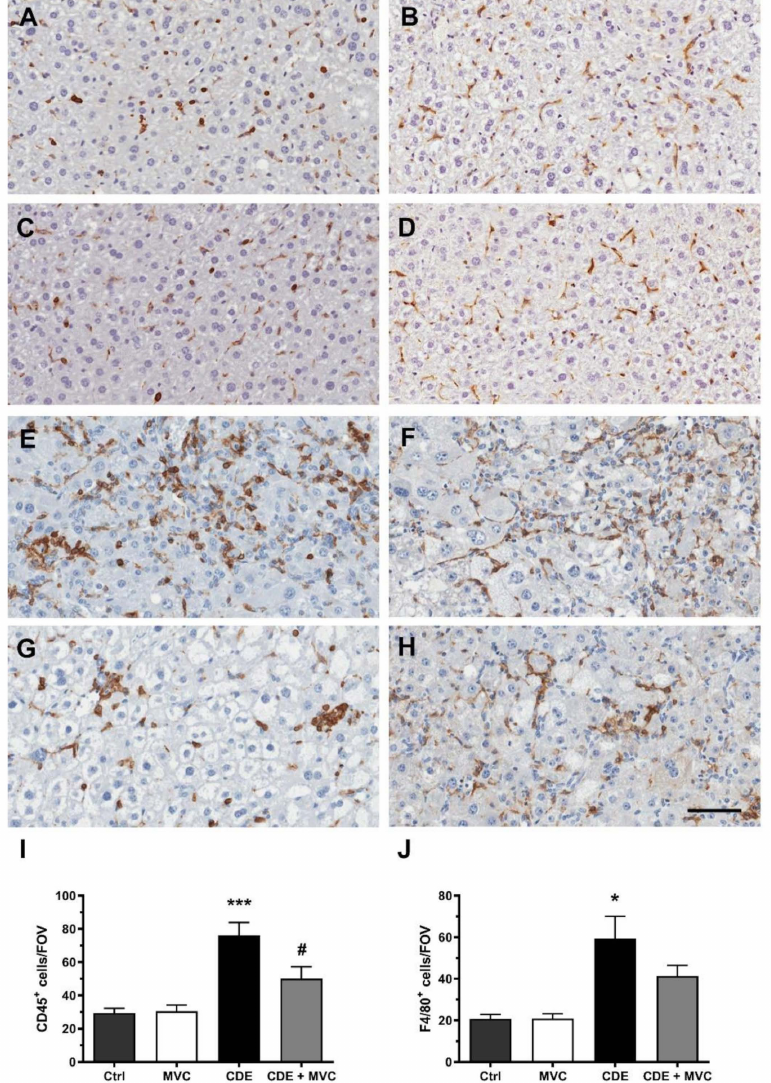
Figure 6. Resident and infiltrating inflammatory cell numbers are attenuated by MVC in CDE liver. Representative images of histological sections stained with CD45 ( A , C , E , G ) or F4/80 ( B , D , F , H ) in Ctrl ( A , B ), MVC ( C , D ), 16-wk CDE ( E , F ) and CDE+MVC ( G , H ) animal groups. ( I , J ) Quantitation of CD45+ and F4/80+ cell numbers per field of view by the inForm software. Bars represent the mean ± SEM for 8, 11, 6 and 14 animals in the Ctrl, MVC, CDE and CDE+MVC groups, respectively. * p < 0.05, *** p < 0.001, compared to Ctrl. # p < 0.05 compared to CDE group. The scale bar represents 50 µ